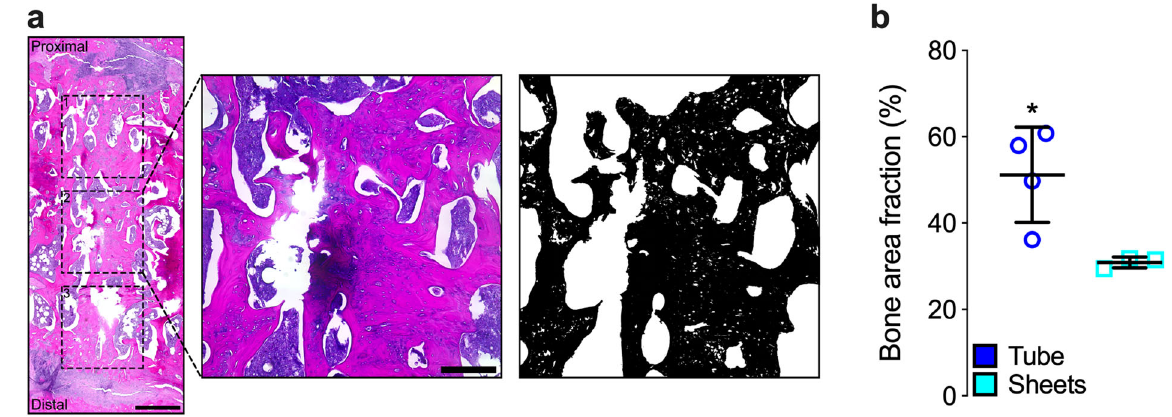
Fig. 8 2-D bone histomorphometric evaluation of femoral defect healing induced by engineered hMSC condensate tubes and sheets. a Representative histological Hematoxylin & Eosin (H&E) staining of a sagittal defect explant section (hMSC tube group; image-oriented distal-to-proximal from bottom-to- top) showing three equal-sized regions of interest in dotted squares that were used to create thresholded black-and-white image masks, with bone tissue in black and all other tissue in white. b Histomorphometric analysis of bone area fraction ( n = 4 (tubes) or 3 (sheets) biologically independent samples per group; an average of three regions of interest per sample; blue circles = hMSC tubes; cyan squares = hMSC sheets). Scale bars, 1 mm and 250 μ m. Individual data points are shown with mean ± SD. Analyzed by unpaired Student ’ s t -test ( p < 0.05 or lower considered signi fi